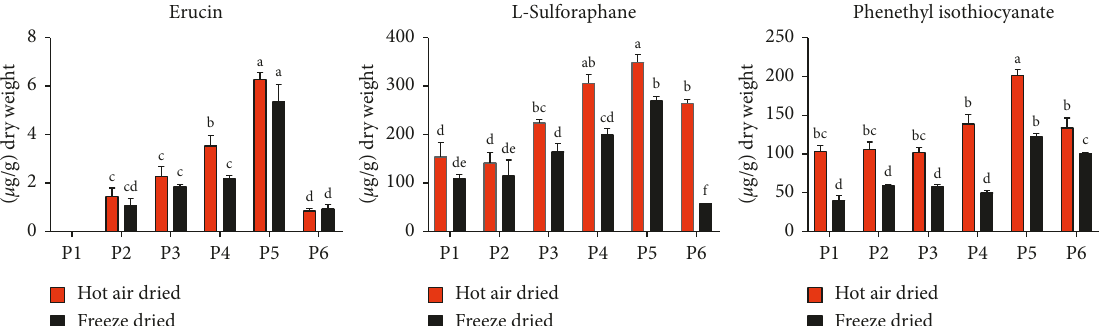
Figure 3: Accumulation of isothiocyanate compounds in different parts of cabbage ( μ g/g DW). Mean and standard deviation obtained from three independent experiments. a–f indicate significant differences ( P < 0 . 05). P1, leaves part 1; P2, leaves part 2; P3, leaves part 3; P4, leaves part 4; P5, leaves part 5, P6, leaves part